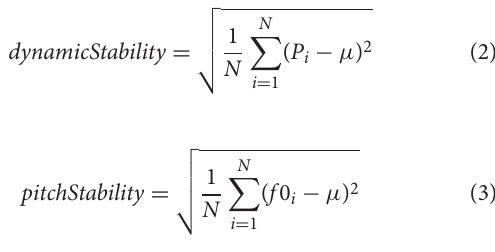
Where angle is the third euler angle measured and 0 the